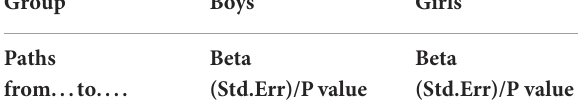
TABLE 7 Estimated means of SDQ-H/I for different levels of PA. Means of SDQ-H/I Means of SDQ-H/ at Wave 1 for I at Wave 2 for the three levels of the three levels PA at Baseline of PA at Wave 1